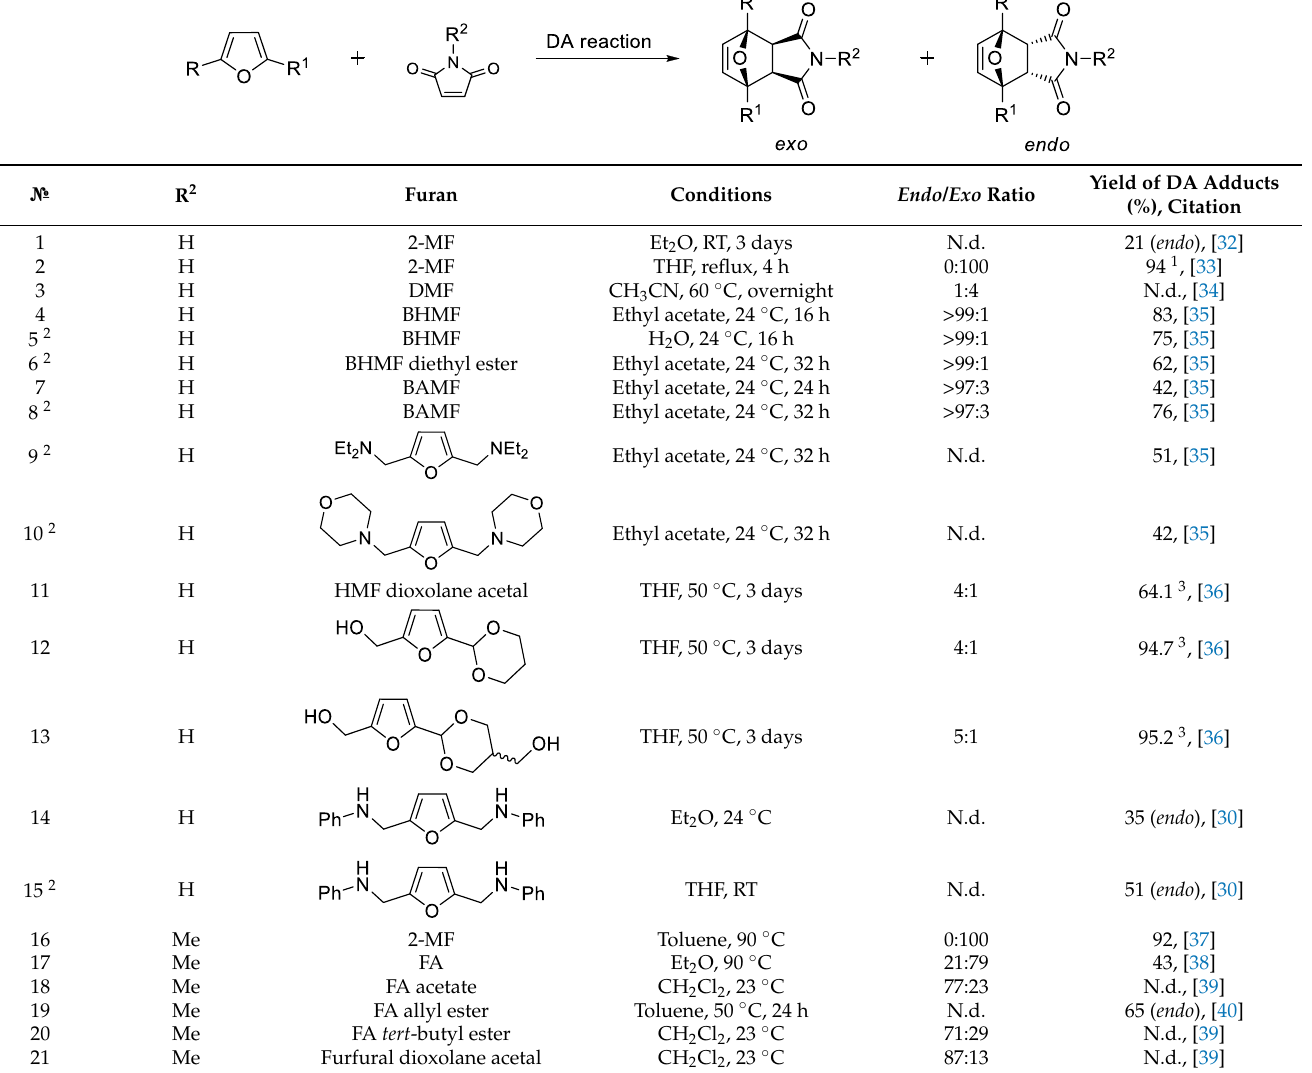
Figure 2. Chemical structures of cantharidin, norcantharidin and norcantharimides. An important parameter of the fmDA reaction that should be taken into account in the development of bioactive compounds is diastereoselectivity, because endo and exo diastereomers can exhibit different biological activity [31]. The literature data on the di- astereoselectivity of the DA reactions between the most common biobased furans and N -alkyl or N -aryl maleimides are summarized in Tables 1 and 2. Based on these data, some typical patterns for the furan/alkene DA reaction [16] were also found for DA reac- tions with maleimides as dienophiles. Table 1. Results of the DA reactions of maleimide and N -alkyl maleimides with biobased furans (selected examples).